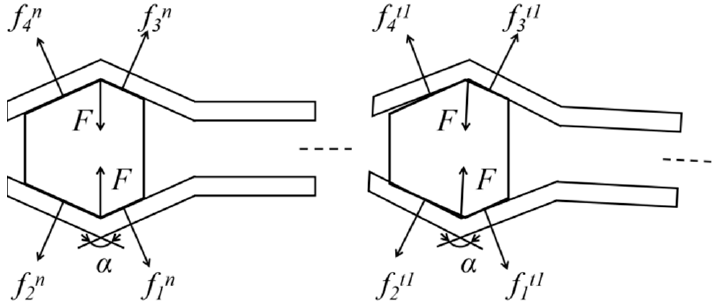
Figure 18. Force analysis of profile model.